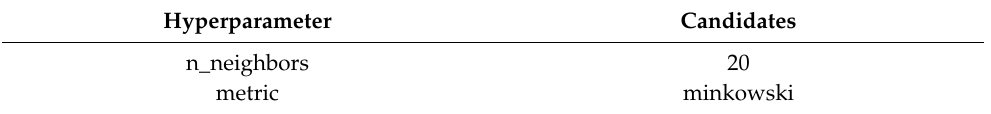
Table 4. LOF algorithm hyperparameters.